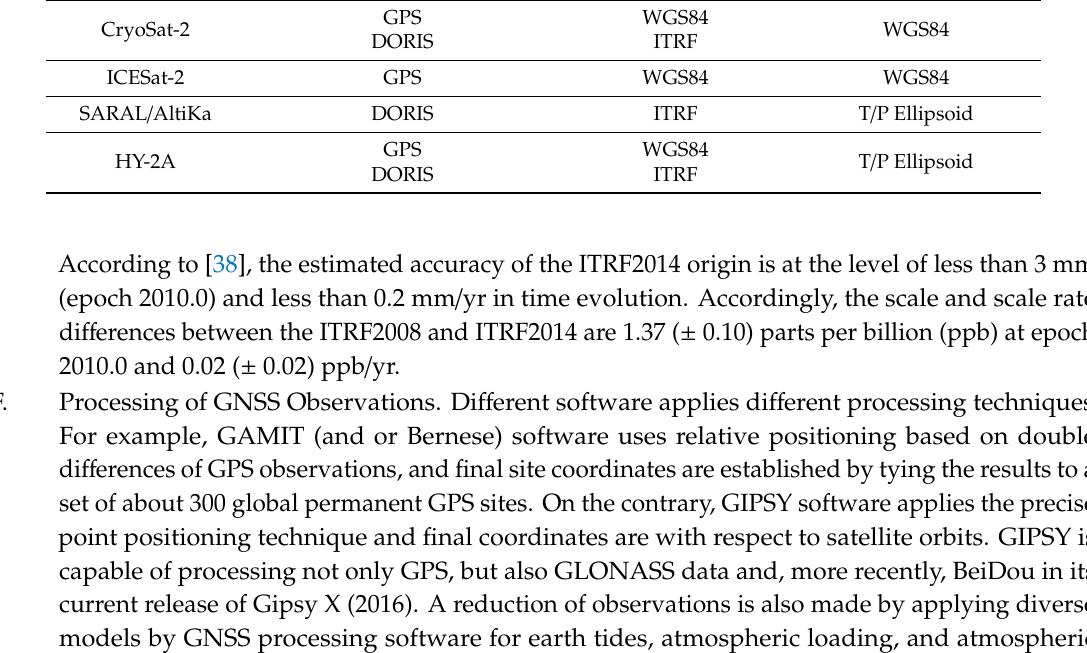
Table 2. Satellite altimeter and the on-board positioning systems along with their reference ellipsoids.